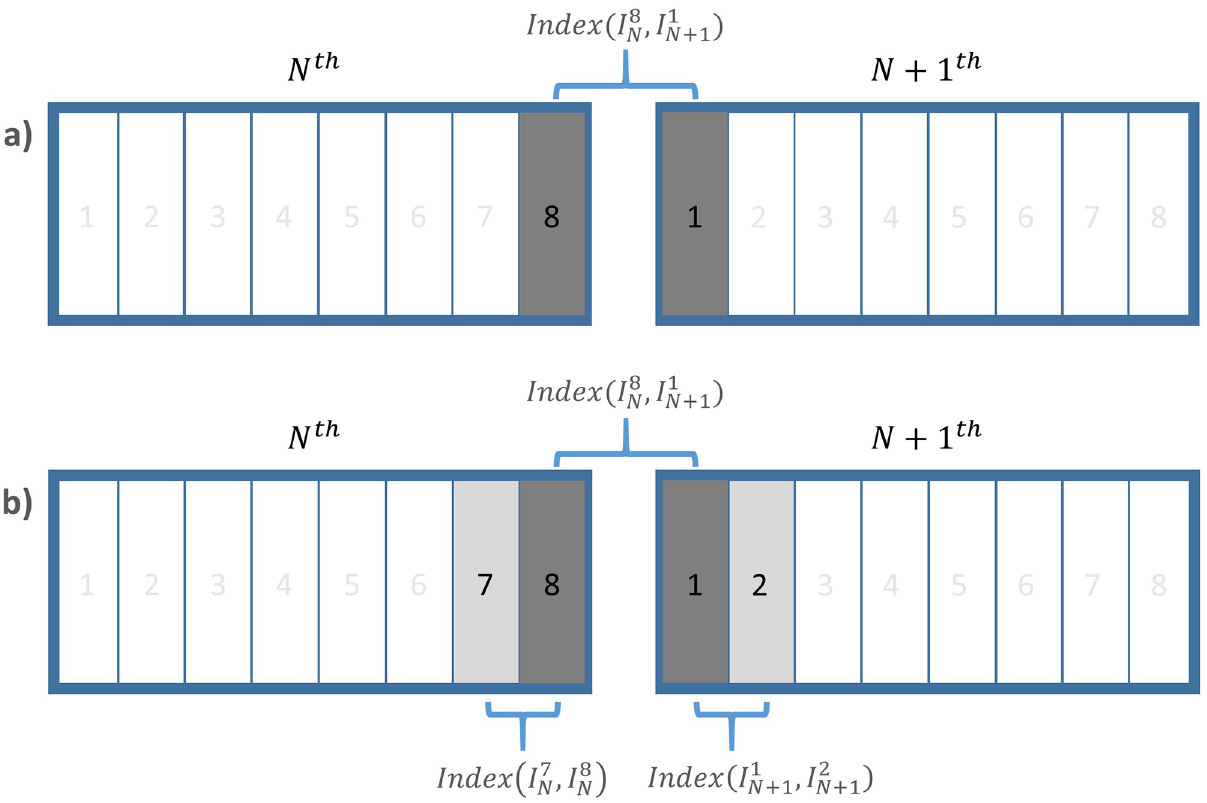
Fig 3. Schematic of the quantitative index for RMA based on the similarity between adjacent CT slices. (a) The quantitative index without the normalisation process and (b) with the additional normalisation process.